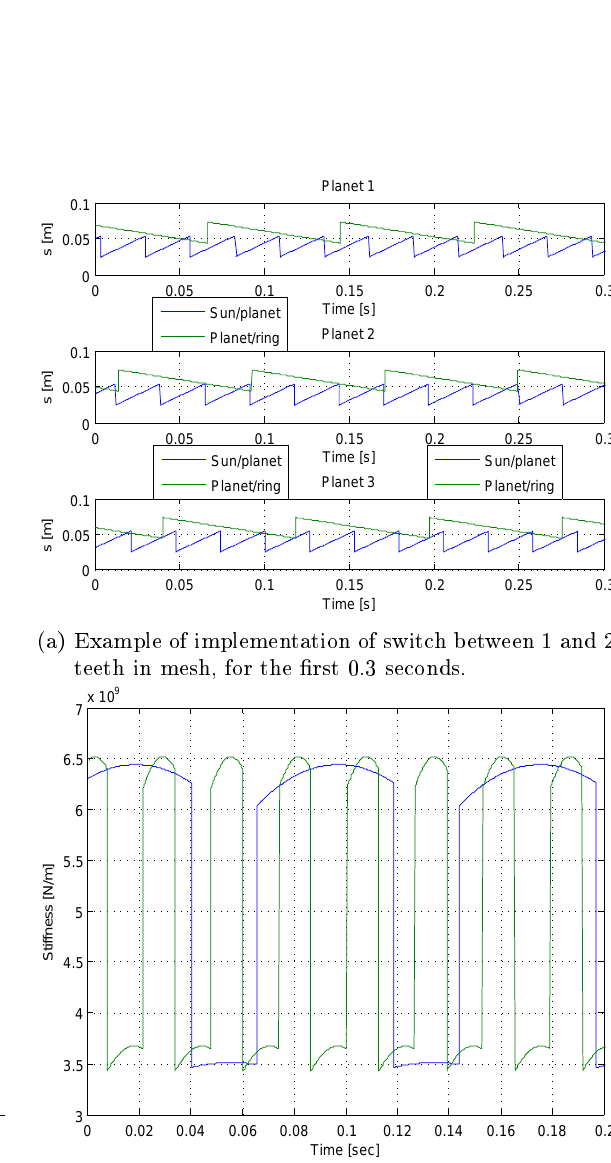
(b) Sti(cid:27)ness variation of one planet due to switch between 1 and 2 teeth in mesh, based on (a). Figure 12: 6-body multibody model and demonstra- tion of realistic sti(cid:27)ness model using pro(cid:28)le shift. If the base circle arc length is below a threshold value, 2 teeth are in mesh and otherwise only a single teeth is in